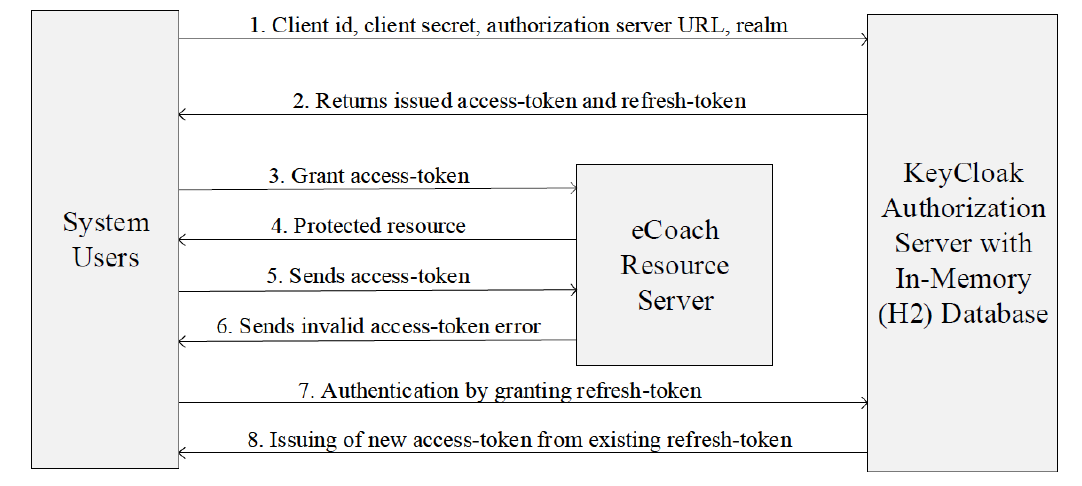
Figure 6. Access-token generation from the existing refresh-token.